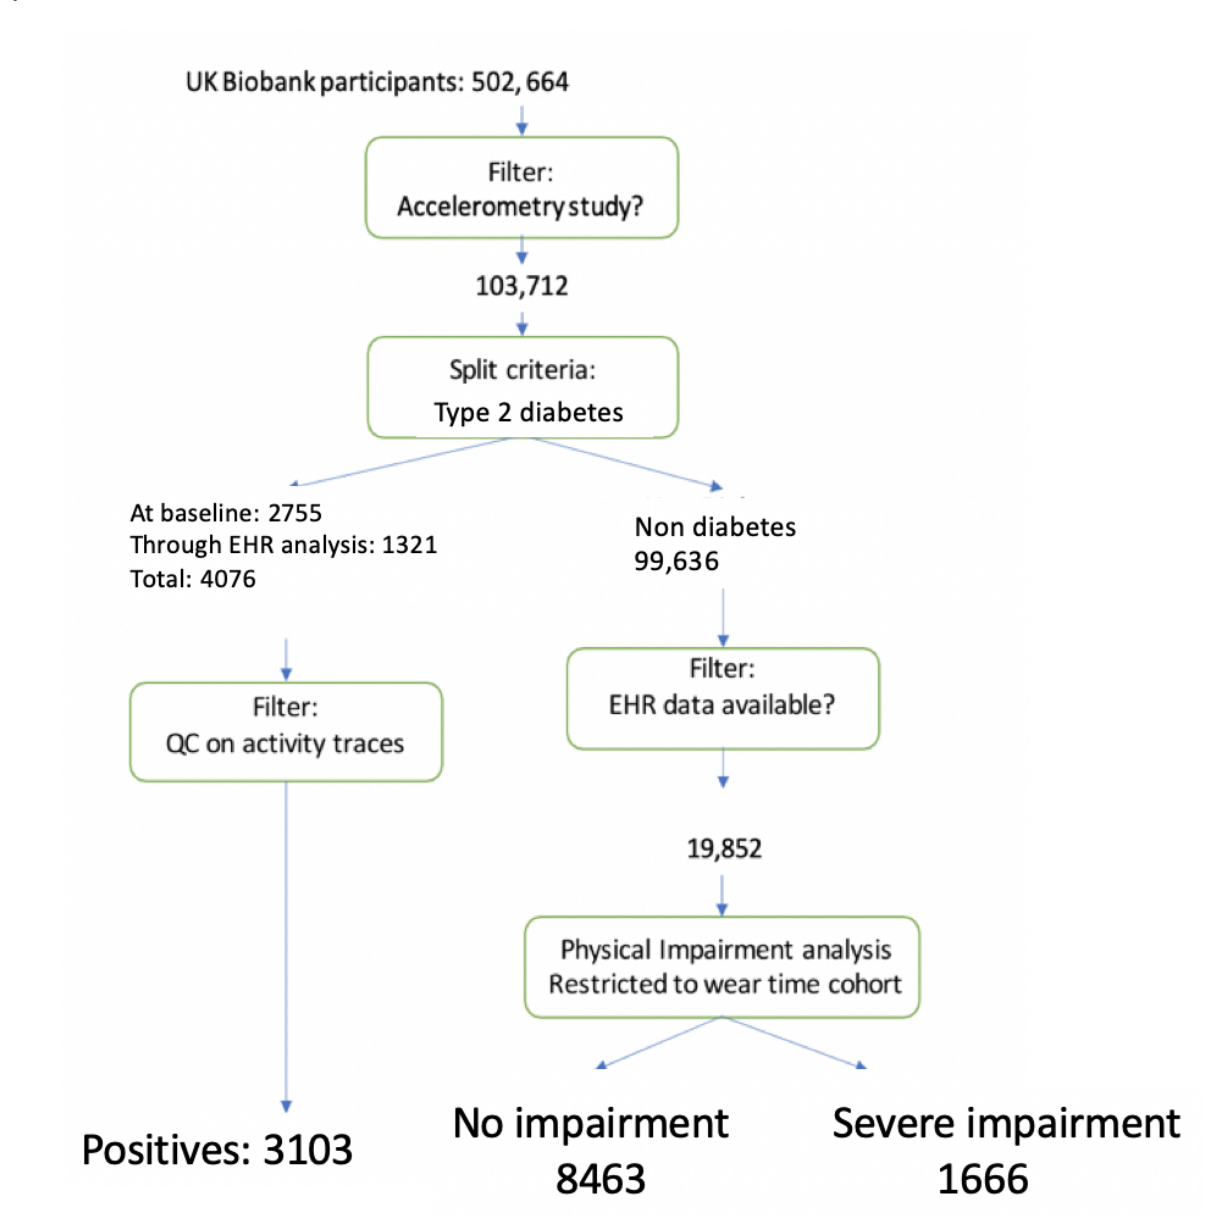
Figure 1. Training set selection criteria for type 2 diabetes–negative and type 2 diabetes–positive individuals. EHR: electronic health record; QC: quality